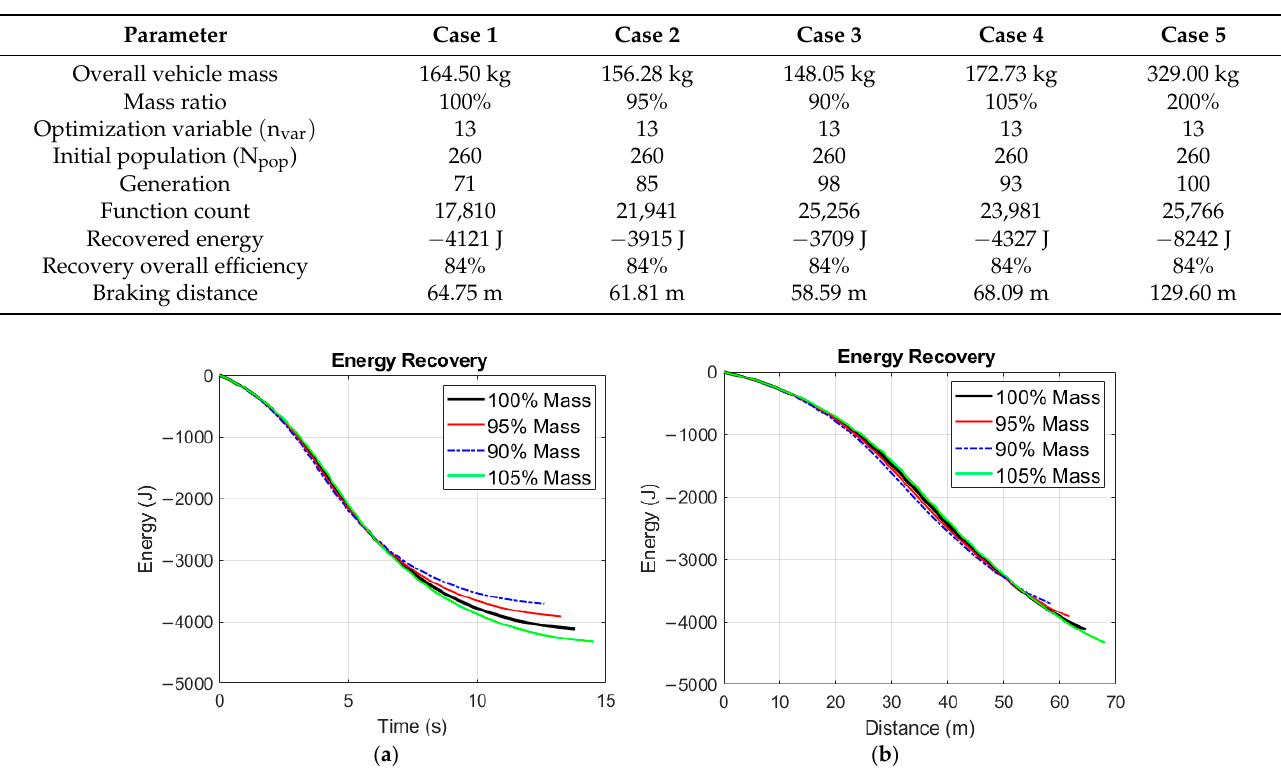
Figure 8. Energy recovery in the case for varied mass optimization attempts: ( a ) energy–time display; ( b ) energy–distance display.